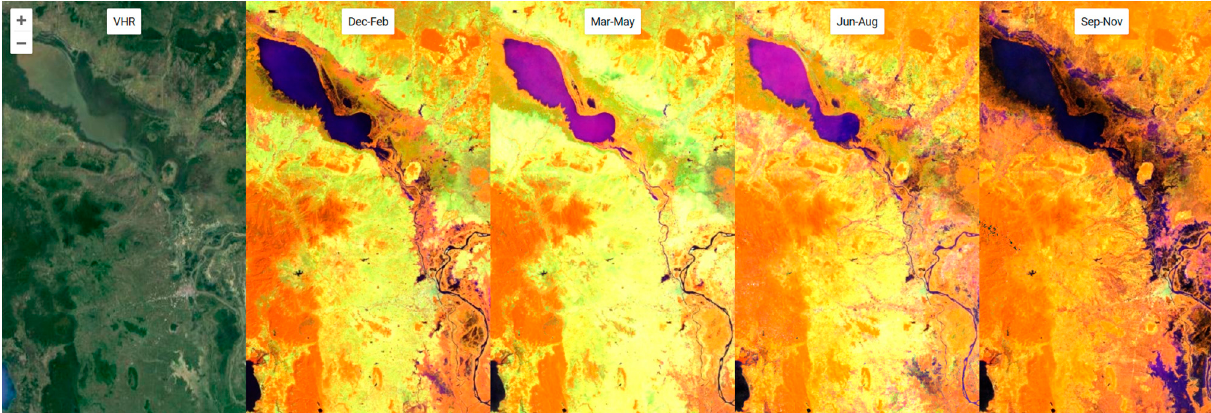
Figure 1. Inter-annual seasonal comparison of the Tonlé Sap Lake and its surrounding floodplain in Cambodia displaying the variation of water extent over the floodplain as well as the variation in water colours. Colours vary from black to dark blue to purple, with reduced depth and increasing temperature and turbidity during the drier seasons. Visualization in Google Earth Engine starting with a VHR (Very High Resolution) image, then showing seasonal variation with Landsat 8 imagery between 2013 and 2022 in the ‘Land/Water’ RGB combination—R,G,B: NIR, SWIR1, Red. Location: WGS84: 12°31 ′ 08.7 ″ N, 104°27 ′ 29.3 ″ E.